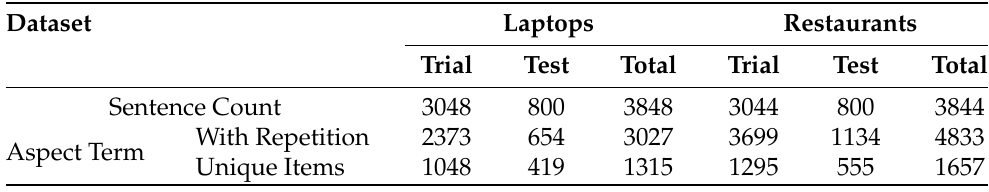
Table 1. The main characteristics of the SemEval-14 datasets.